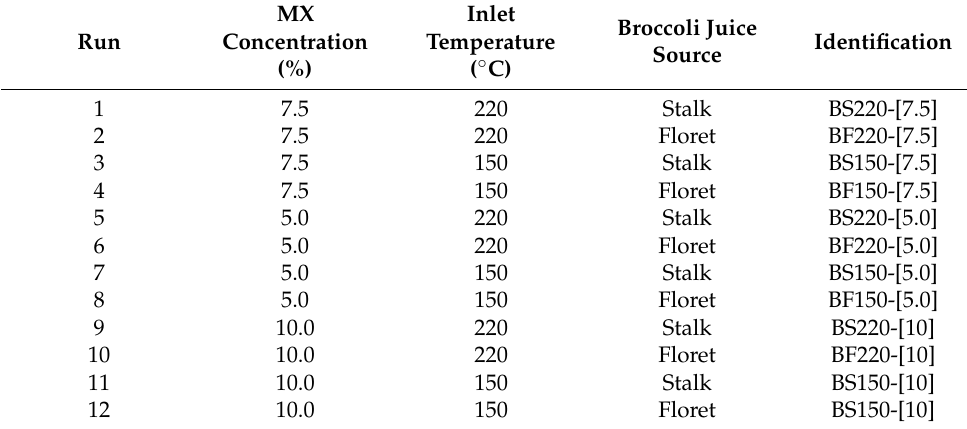
Table 1. Experimental design employed to determine the optimal drying condition of BJ-MX